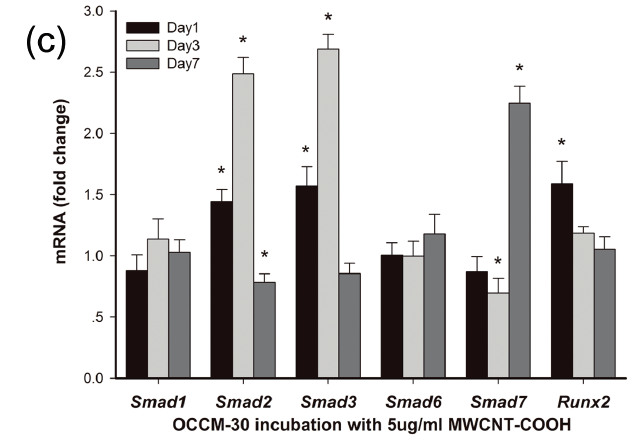
Figure 4. Results of gene expression. ( a ) Expression of genes associated with differentiation and mineralization of cementoblasts exposed to various concentrations of MWCNT-COOH; ( b ) time-course of the gene expression of cementoblasts in response to 5 µg/mL MWCNT-COOH; ( c ) expression of the runt-related transcription factor 2 ( Runx2 ) and Smad genes of cementoblasts in response to 5 µg/mL MWCNT-COOH. Data are shown as the mean ± SD ( * p < 0.05; ** p < 0.001). 2.4. Effects of MWCNT-COOH on OCCM-30 Cementoblast Smad Proteins